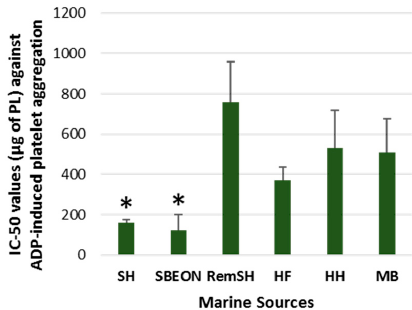
Figure 3. Antithrombotic activities of PL extracts from salmon, herring, and boarfish by-products against adenosine diphosphate (ADP)-induced aggregation of human platelets. Results are expressed as IC 50 (half-maximal inhibitory concentration) values that reflects the inhibitory strength of each